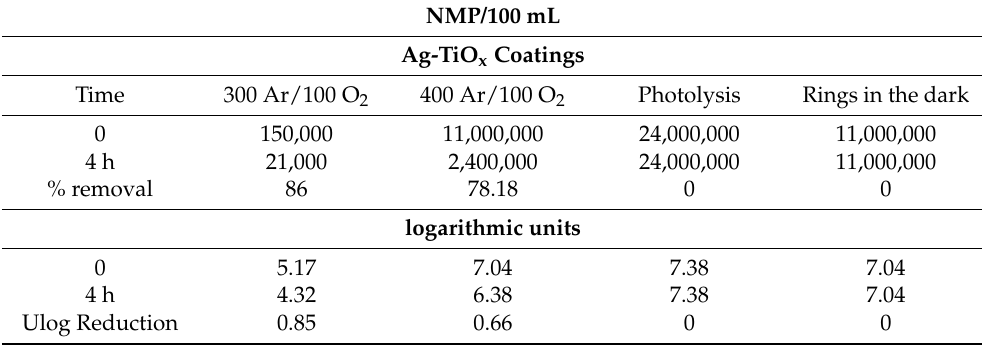
Table 7. Concentration of fecal coliforms in NMP/100 mL and Ulog in synthetic water using Ag-TiO x arc-PVD coatings on rings.